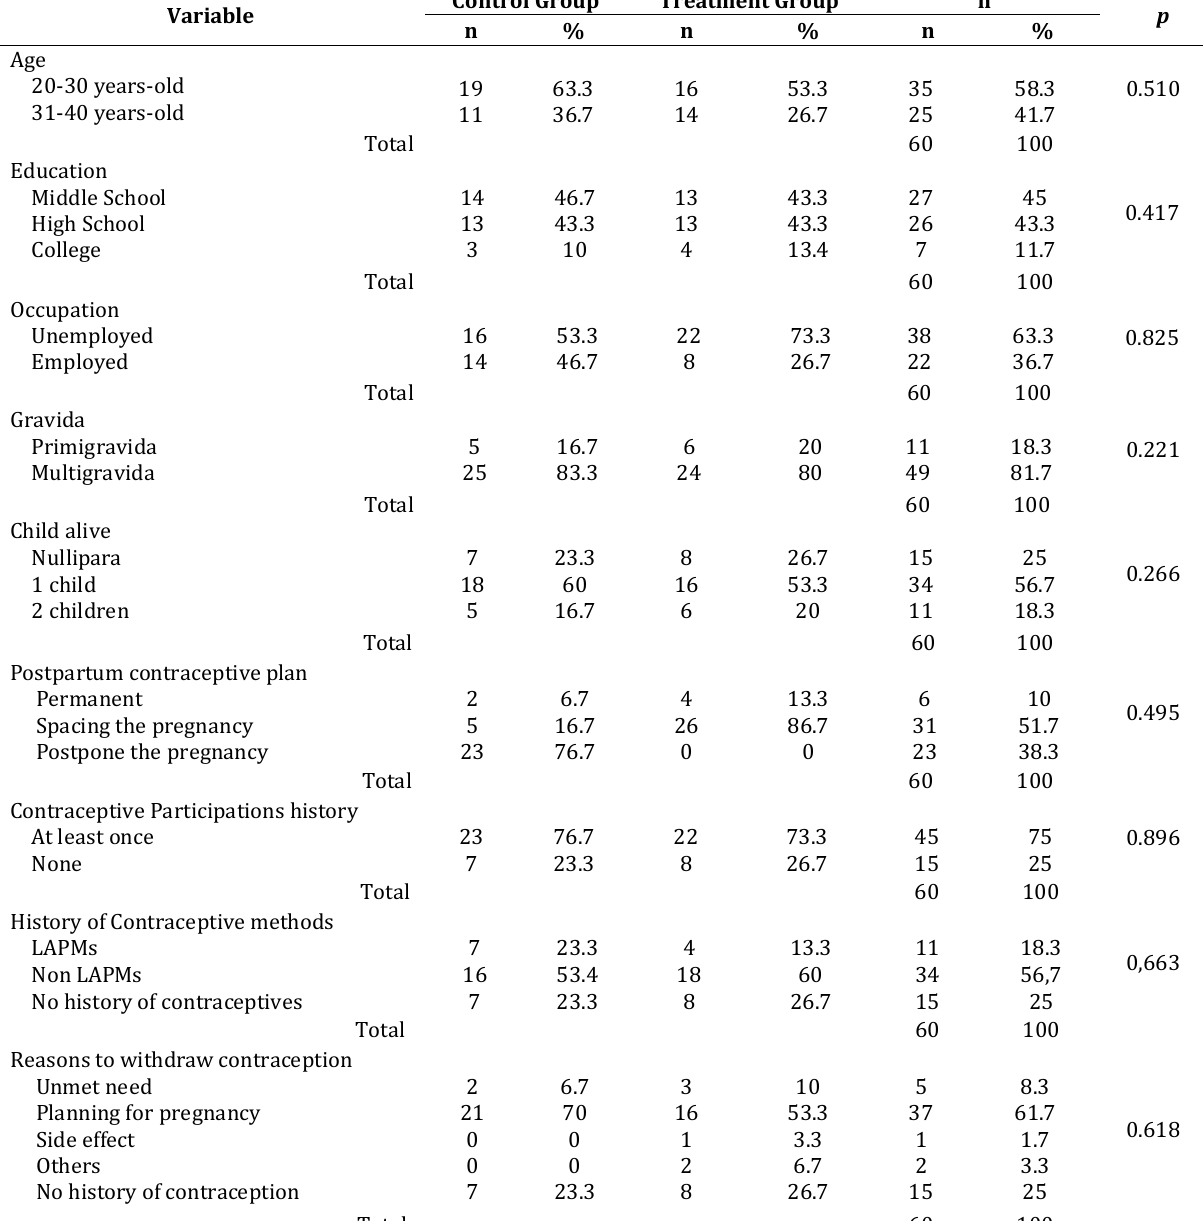
Table 1. Participants’ Characteristics in the Control and Intervention